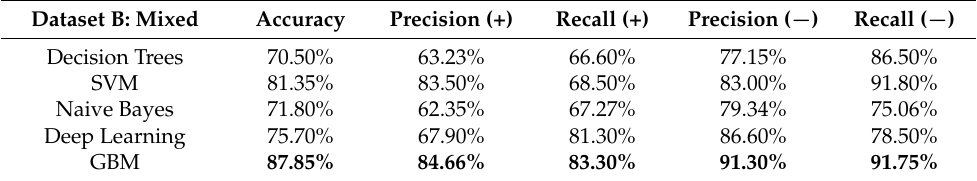
Table 4. Performance of GBM against other benchmarking methods for Dataset B: Mixed. Dataset B: Mixed